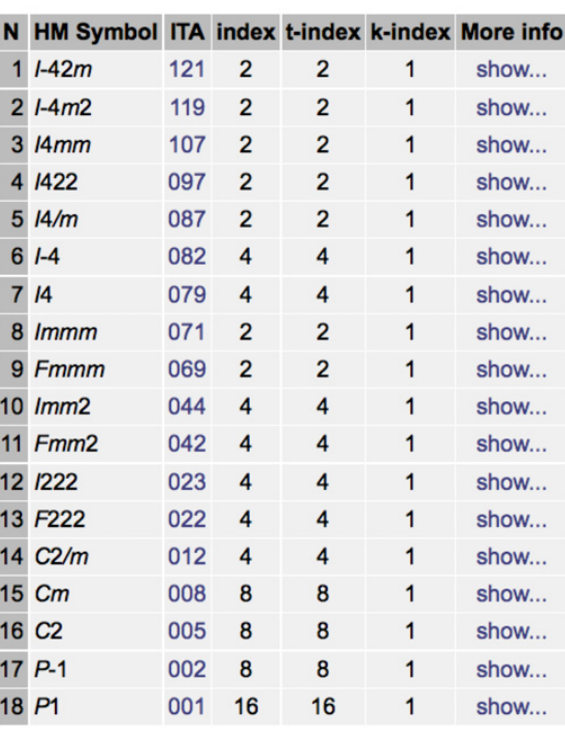
Figure 2. Subgroup types of I 4 /mmm with i k = 1, as given by CELLSUB